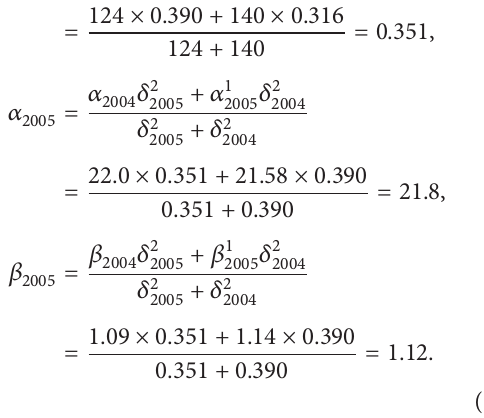
Figure 3: The value of parameter ( 𝛽 ). 124 × 0.390 + 140 × =